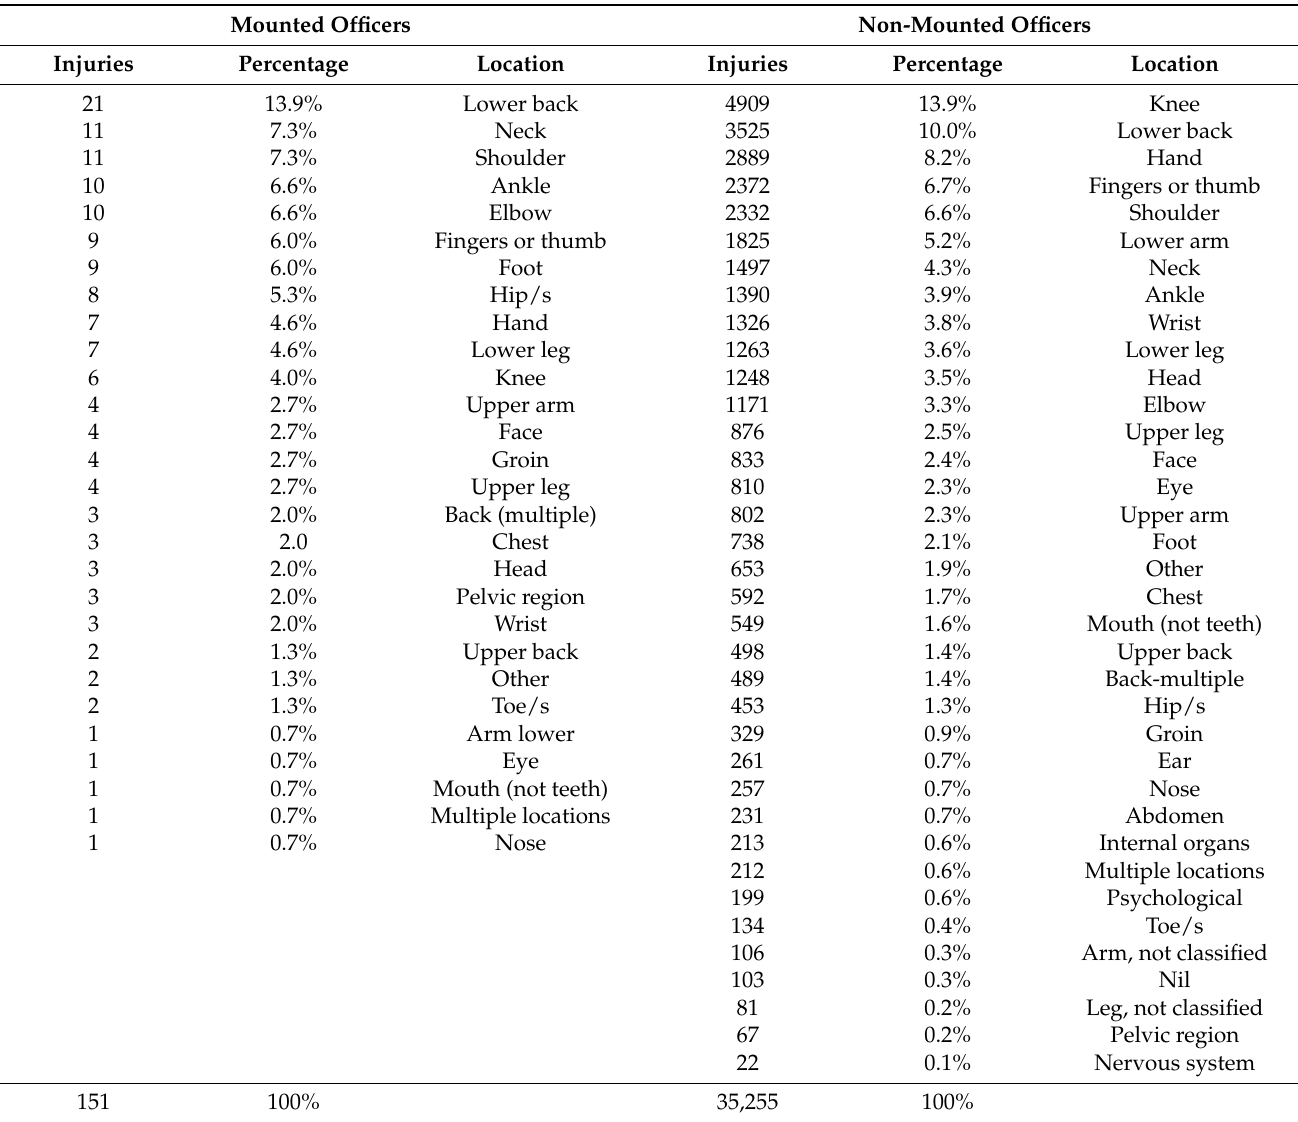
Table 6. Injuries by body